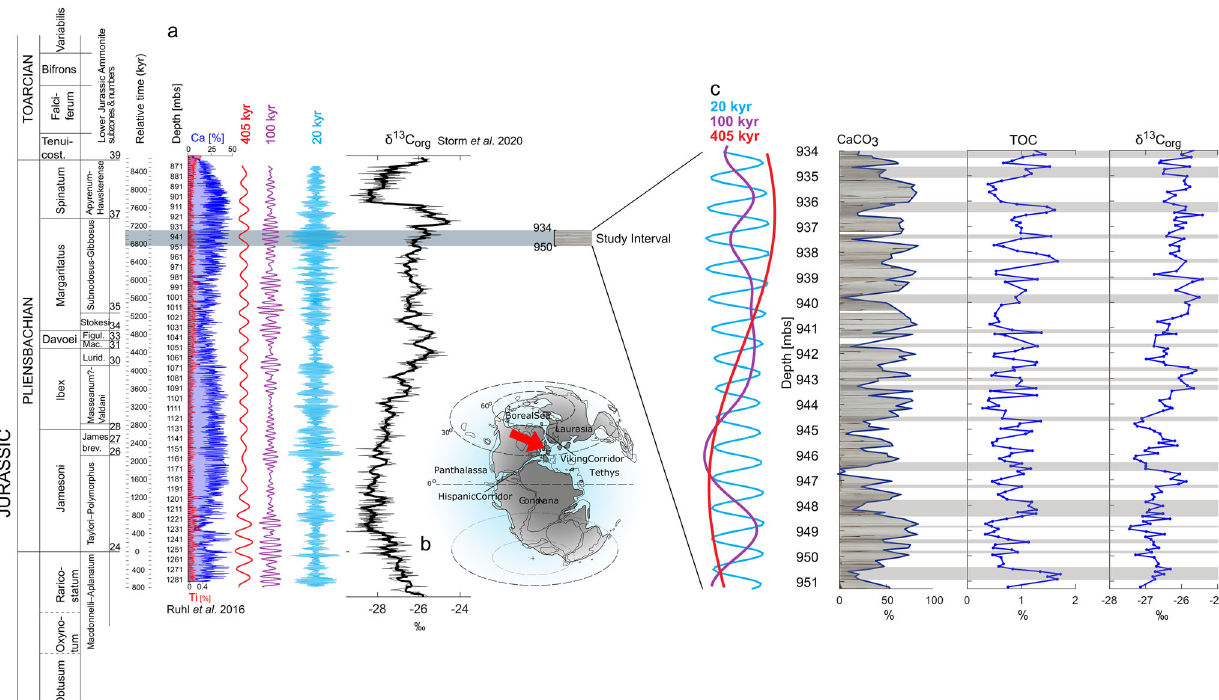
Fig. 1 Stratigraphic context of the Mochras borehole in the Upper Pliensbachian (934 – 951 mbs), Margaritatus Zone, Subnodosus-Gibbosus subzones. a The Mochras borehole has been cyclostratigraphical tuned based on two independent geochemical time series, elemental Ca record 43,45 and δ 13 C org 46 . The sampled interval for this study shows strong orbital forcing 43 and is within the stable part of the δ 13 C org record 46 , allowing examination of climatic background fl uctuations and the effects of Milankovitch cycles on the charcoal record. b The Mochras borehole was located at a palaeo-latitude of ~35°N 85 , within the Laurasian Seaway 86,87 south of the Viking Corridor that linked the NW Tethys Ocean to the Boreal Sea 88 . Reprinted from ref. 43 . Copyright (2021) with permission from Elsevier. c Detail of the fi ltered orbital periodicities in the Pliensbachian carbonate record 43 are plotted next to data from this study, and span approximately 350 kyr 43,45 . Clear alternations of carbonate-rich and TOC-enhanced lithological couplets are observed at a metre scale, which are forced by precession 43 . Finally, high resolution δ 13 C org data con fi rms that the 934 – 951 mbs interval contains only a minor swing of ~0.5 ‰